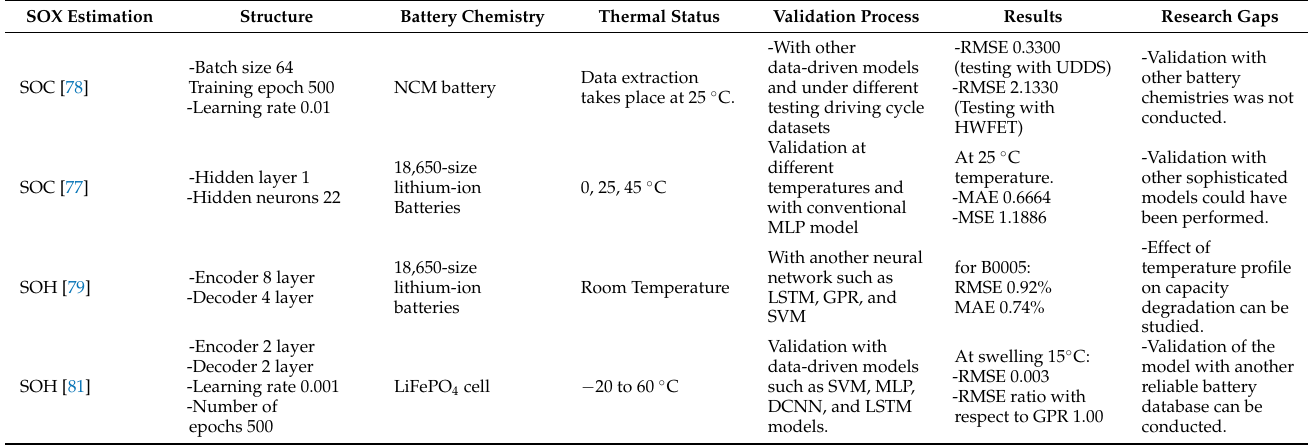
Table 6. Summary of autoencoder-based SOX estimation